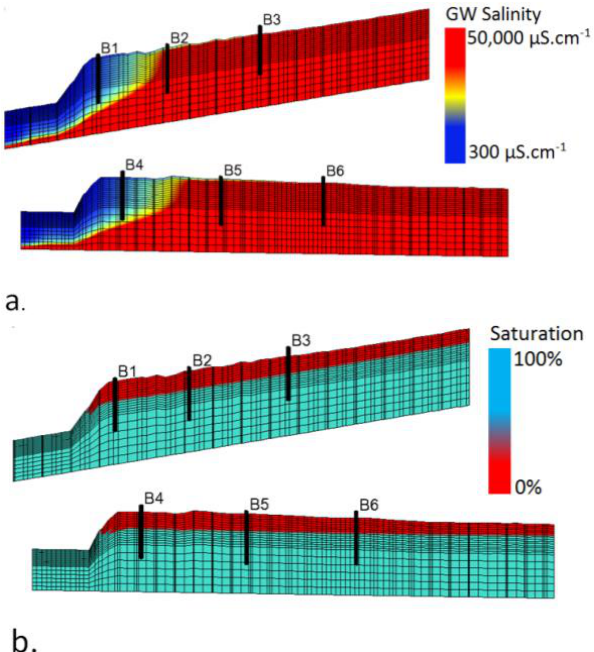
Fig. 4. 3-D demonstration of simulated initial condition along tran- sects B1 and B2: (a) porous media saturation, (b) solute concentra- tion distribution. Observation wells are in